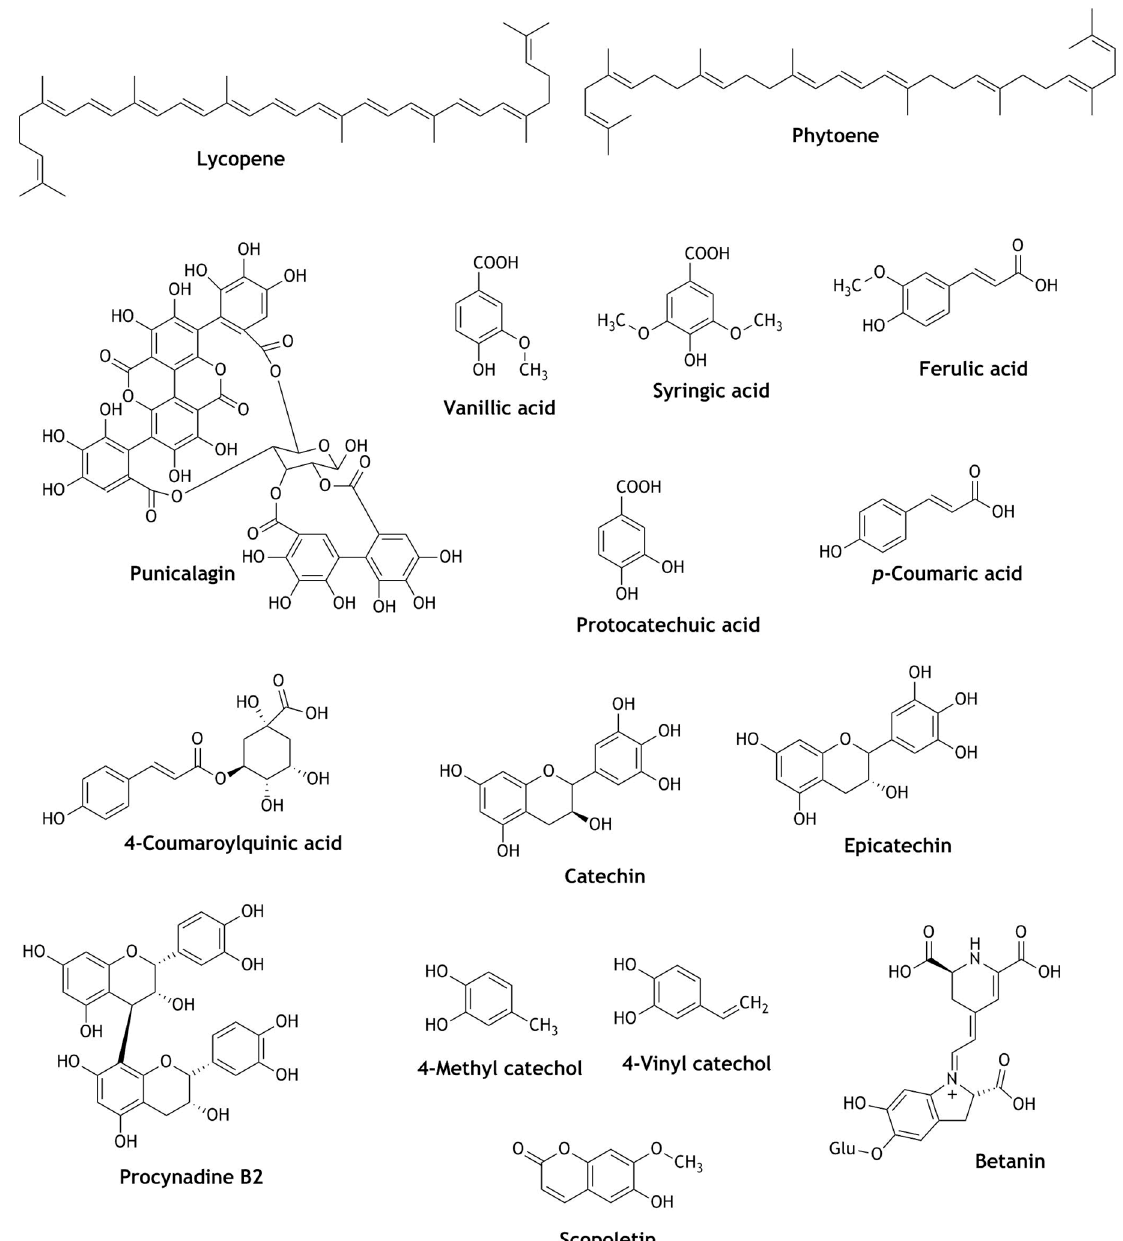
Figure 5. Structures of phytochemicals identified in fruit juices as Nrf2 activators.